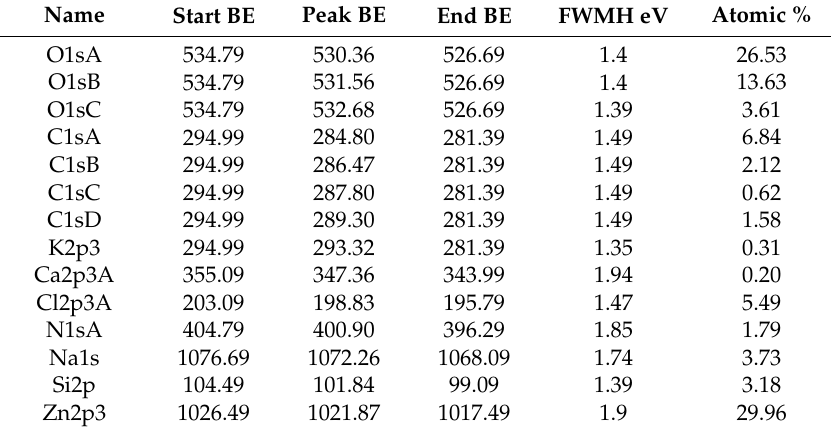
Table 2. XPS results showing the elements with binding energy (BE) and atomic % of the synthesized ZnO nanoparticles.